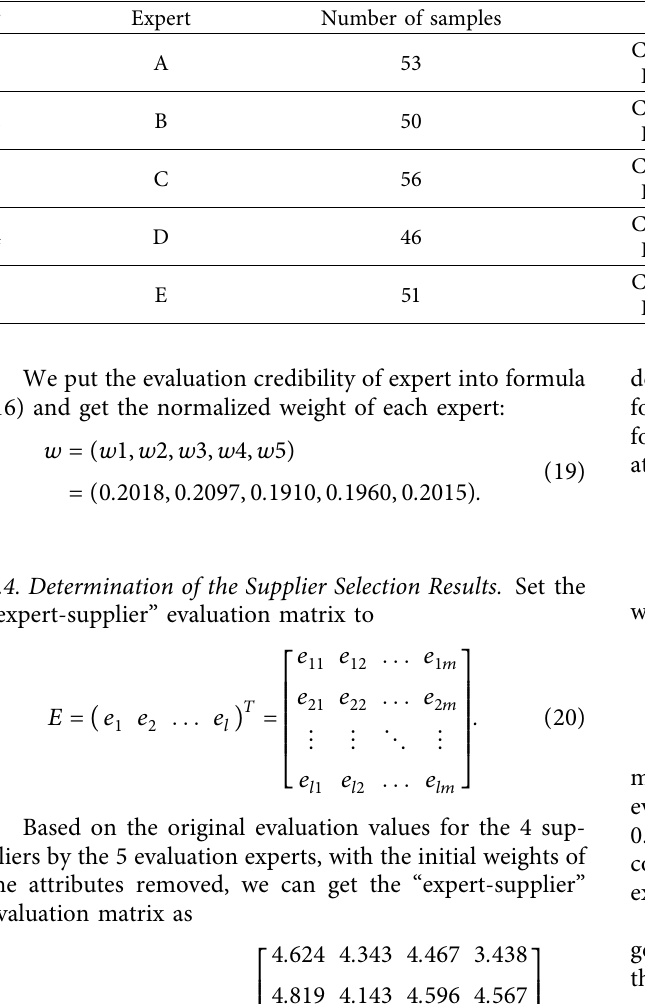
Table 4: Results of classification of evaluation data and evaluation credibility of